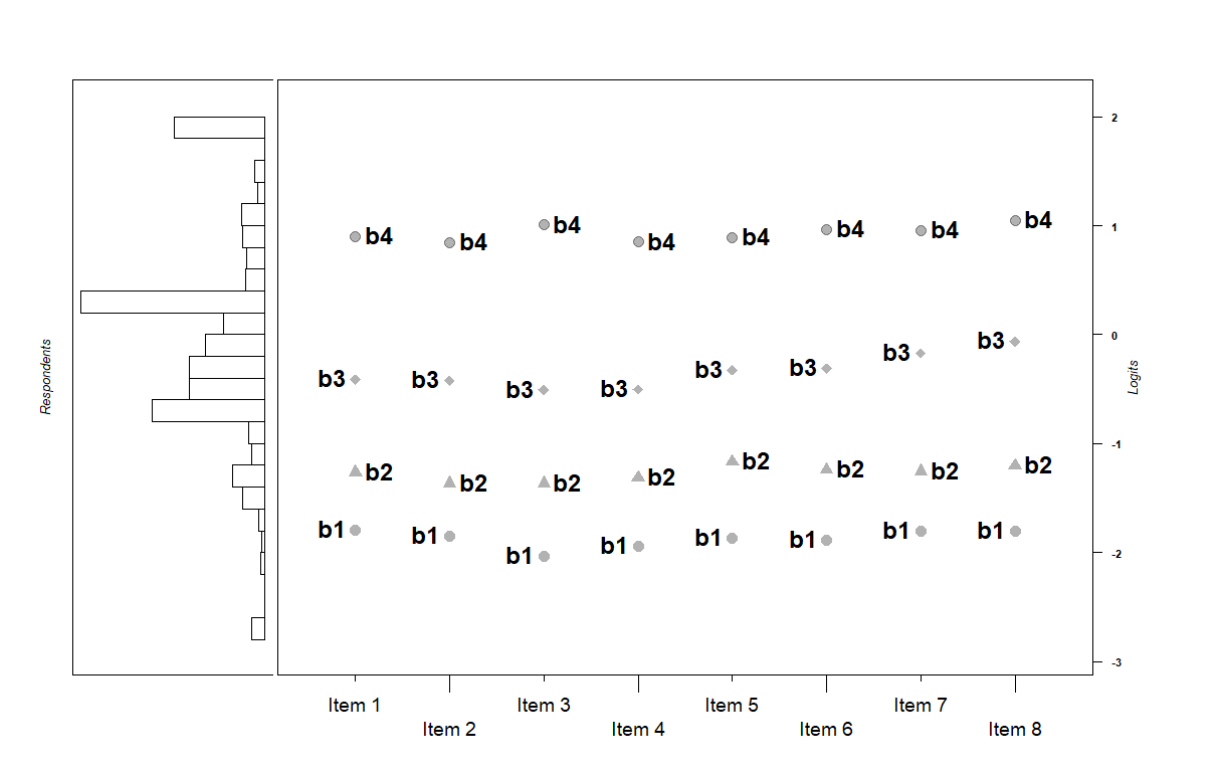
Figure 3. Item-person map of the simplified Chinese eHealth literacy scale. b: coefficient of